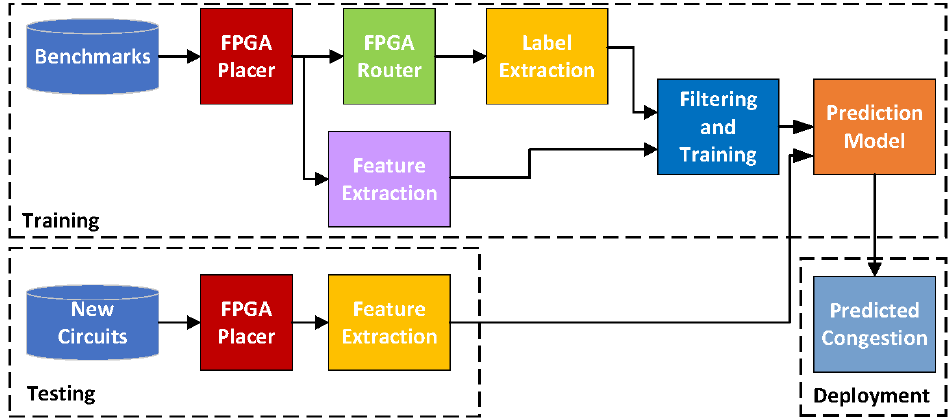
Figure 9. Placement using machine